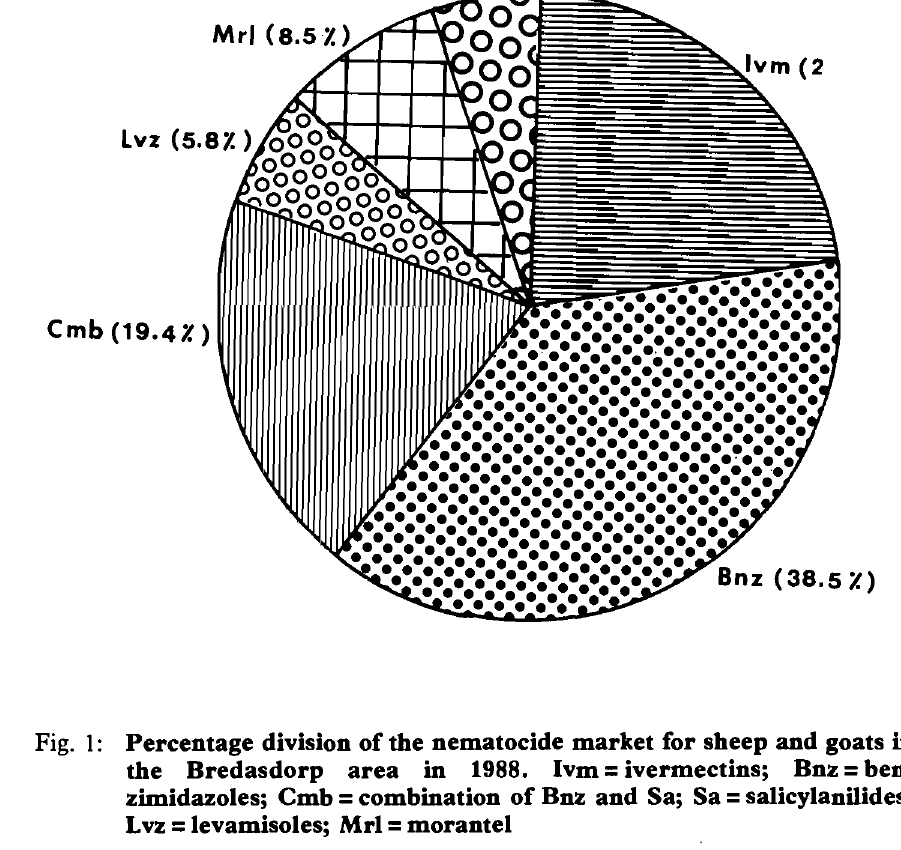
Fig. I: Percentage division of the nematocide market for sheep and goats in = = the Bredasdorp area in 1988. Ivm ivermectins; Bnz ben zimidazoles; Cmb = combination of Bnz and Sa; Sa = salicylanilides; = = Lvz levamisoles; Mrl morantel